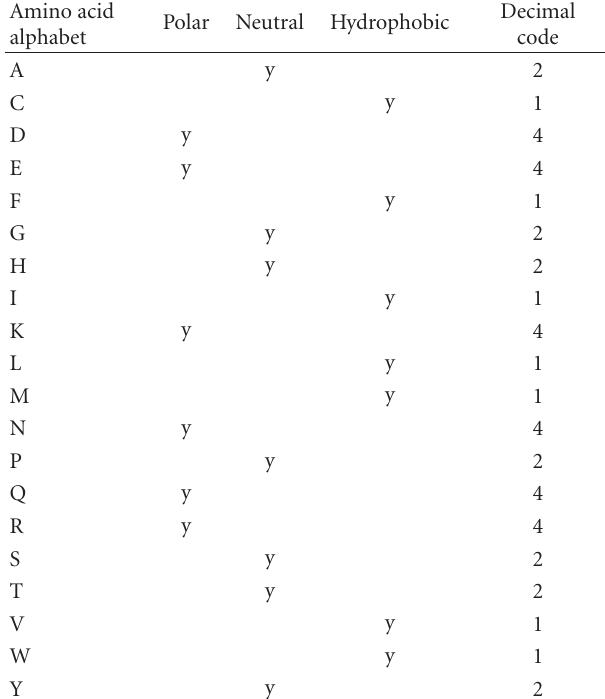
Table 5: Relative hydrophobic value of amino acids of the third